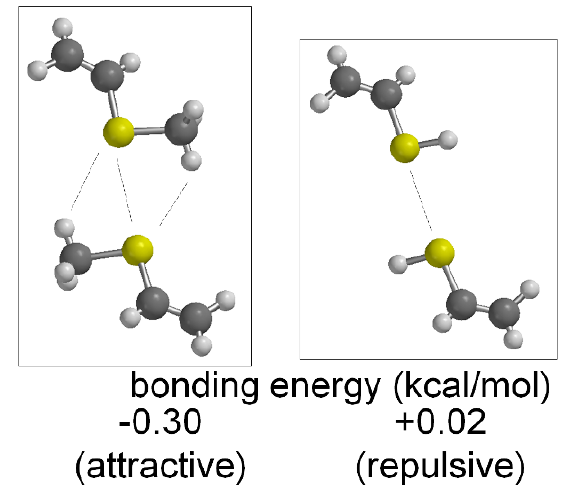
Figure 6. Simple models of the columnar structure of 1,6,12,17- tetrathiacyclodocosa-2,4,13,15-tetrayne in the solid state; heavy-atom positions correspond to the crystal structure [19,20], while the positions of the hydrogens are geometry-optimized. Dashed lines represent potential non-covalent interactions. “Bonding energies” are obtained using MP2/6-311+G**, and represent differences in energy between structures shown here and hypothetical non-equilibrium structures obtained by simple elongation of the S-S distance along the S-S axis, from the equilibrium distance of 3.473 Å to 3.872 Å (arbitrarily chosen to be somewhat longer than the sum of van der Waals radii).